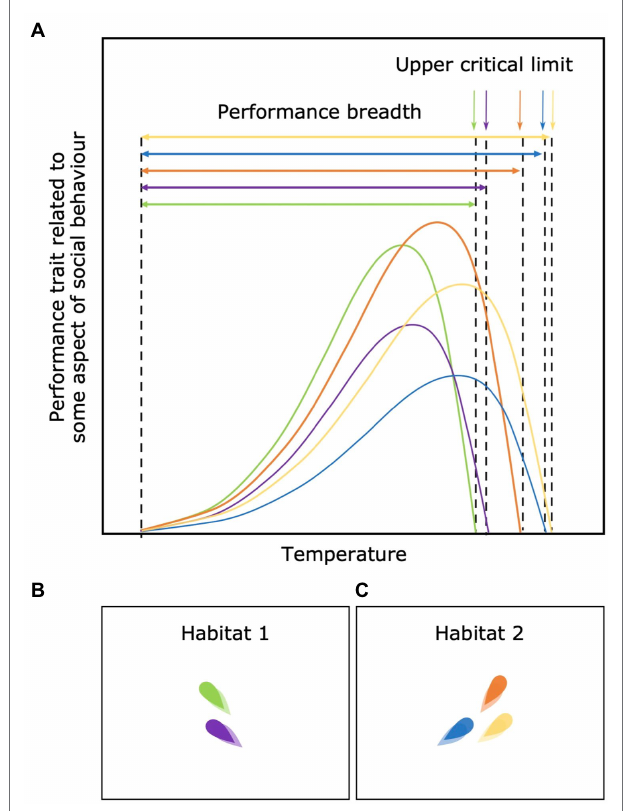
FIGURE 7 | Among-individual differences in performance breadth and critical limits (A) and its consequences (B,C) . Variation in the breadth and critical thresholds limit the options of habitats available for each individual and promote among-group assortment [e.g. (B,C)